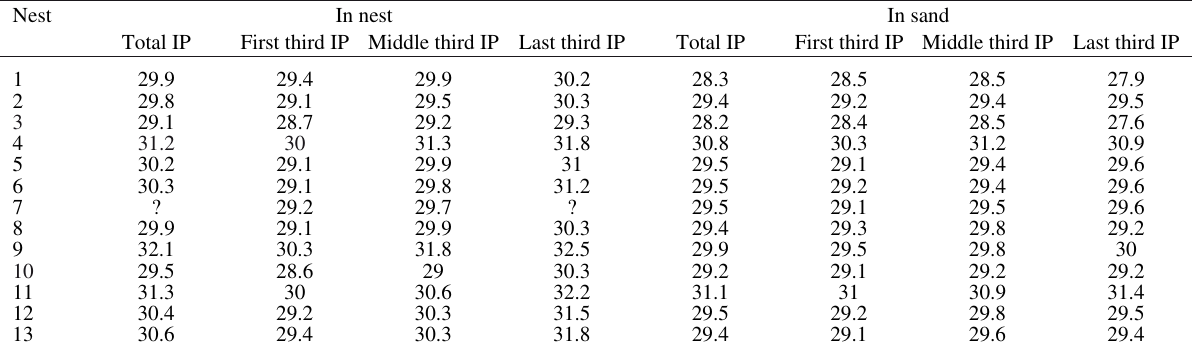
Table 3. – Mean temperature in study nests and adjacent sand during different incubation periods. IP, incubation period. The data logger in nest 7 stopped during the last third of the IP. Nest In nest In sand Total IP